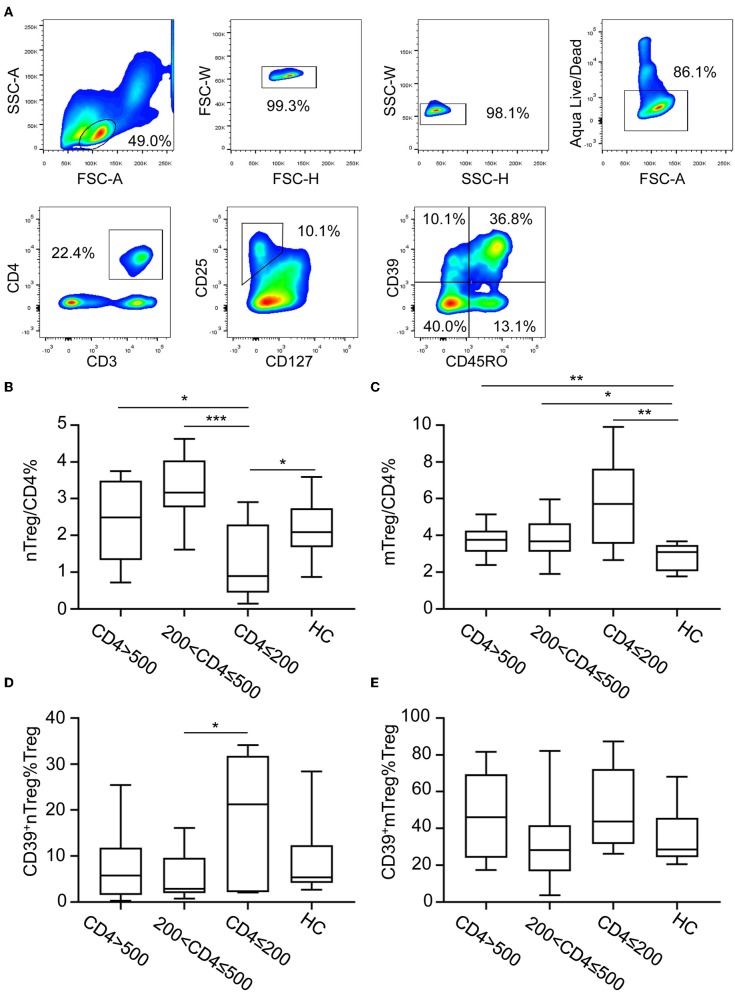
CD39 expression on nTreg and mTreg cells of HIV-infected participants. (A) Gating strategy for flow cytometry analysis. Cells were first gated for lymphocyte and singlets. Live cells were discriminated using Aqua Live/Dead staining kit. Tregs cells were further identified base on CD25 and CD127 expression and CD39 expression on nTreg and mTreg cells were analyzed. (B–E) Anti-retroviral therapy naïve HIV-infected patients were stratified into three groups according to absolute CD4+ T cell counts: CD4 ≤200 cells/μL, 200< CD4 ≤500 cells/μL, and CD4 >500 cells/μL. The frequency of nTreg (B) and mTreg (C) cells among total CD4+ T cells in each group. Frequencies of CD39+ nTregs (D) and CD39+ mTregs (E) among Treg cells in each group. Statistical significance between two groups was determined by a Mann–Whitney U-test. *P < 0.05, **P < 0.01, ***P <0.001.